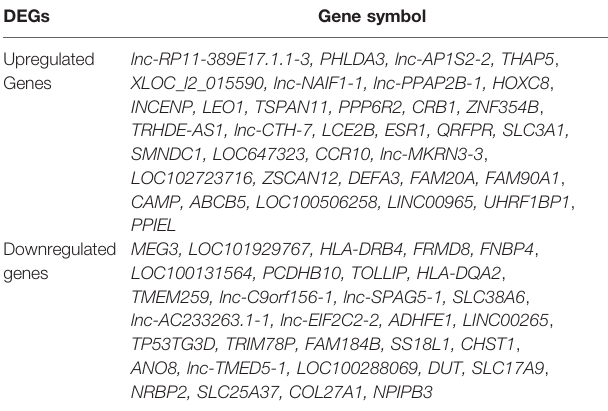
TABLE 1 | Sixty-six DEG were recognized in GSE117999.